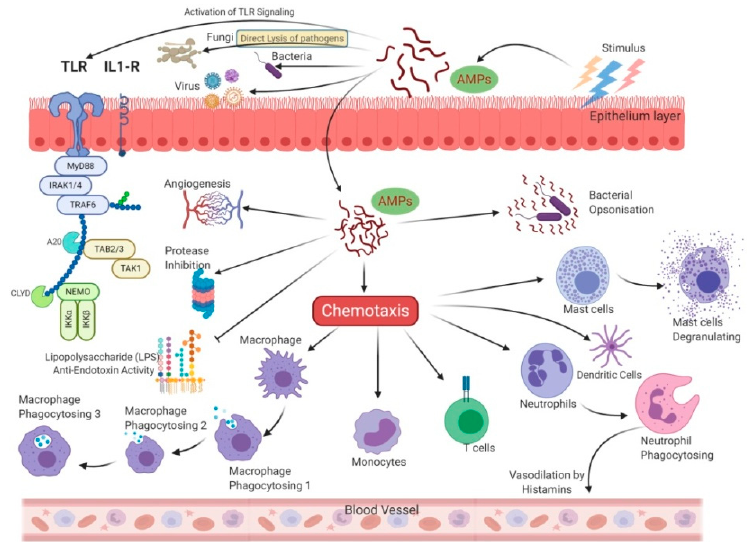
Figure 4. Allied and indirect bioactivities are associated with the AMPs sequence. In addition to direct antimicrobial activity, AMPs also trigger intracellular changes resulting in the activation of anti-inflammatory cytokines, immunomodulation, and promotion of non-specific immunity and wound healing.